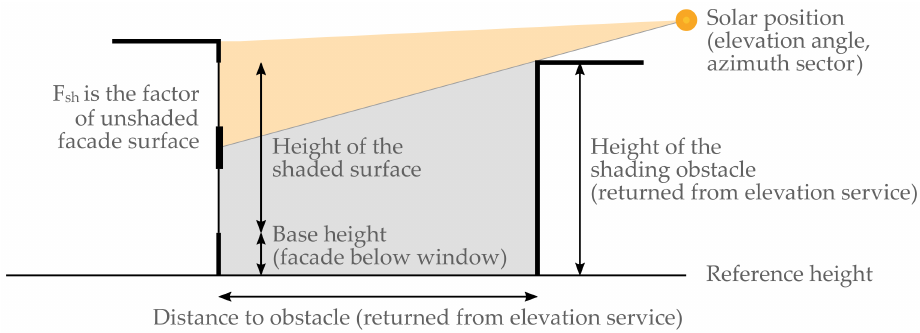
Figure 6. Shading of direct and circumsolar beam irradiance and the vertical shading